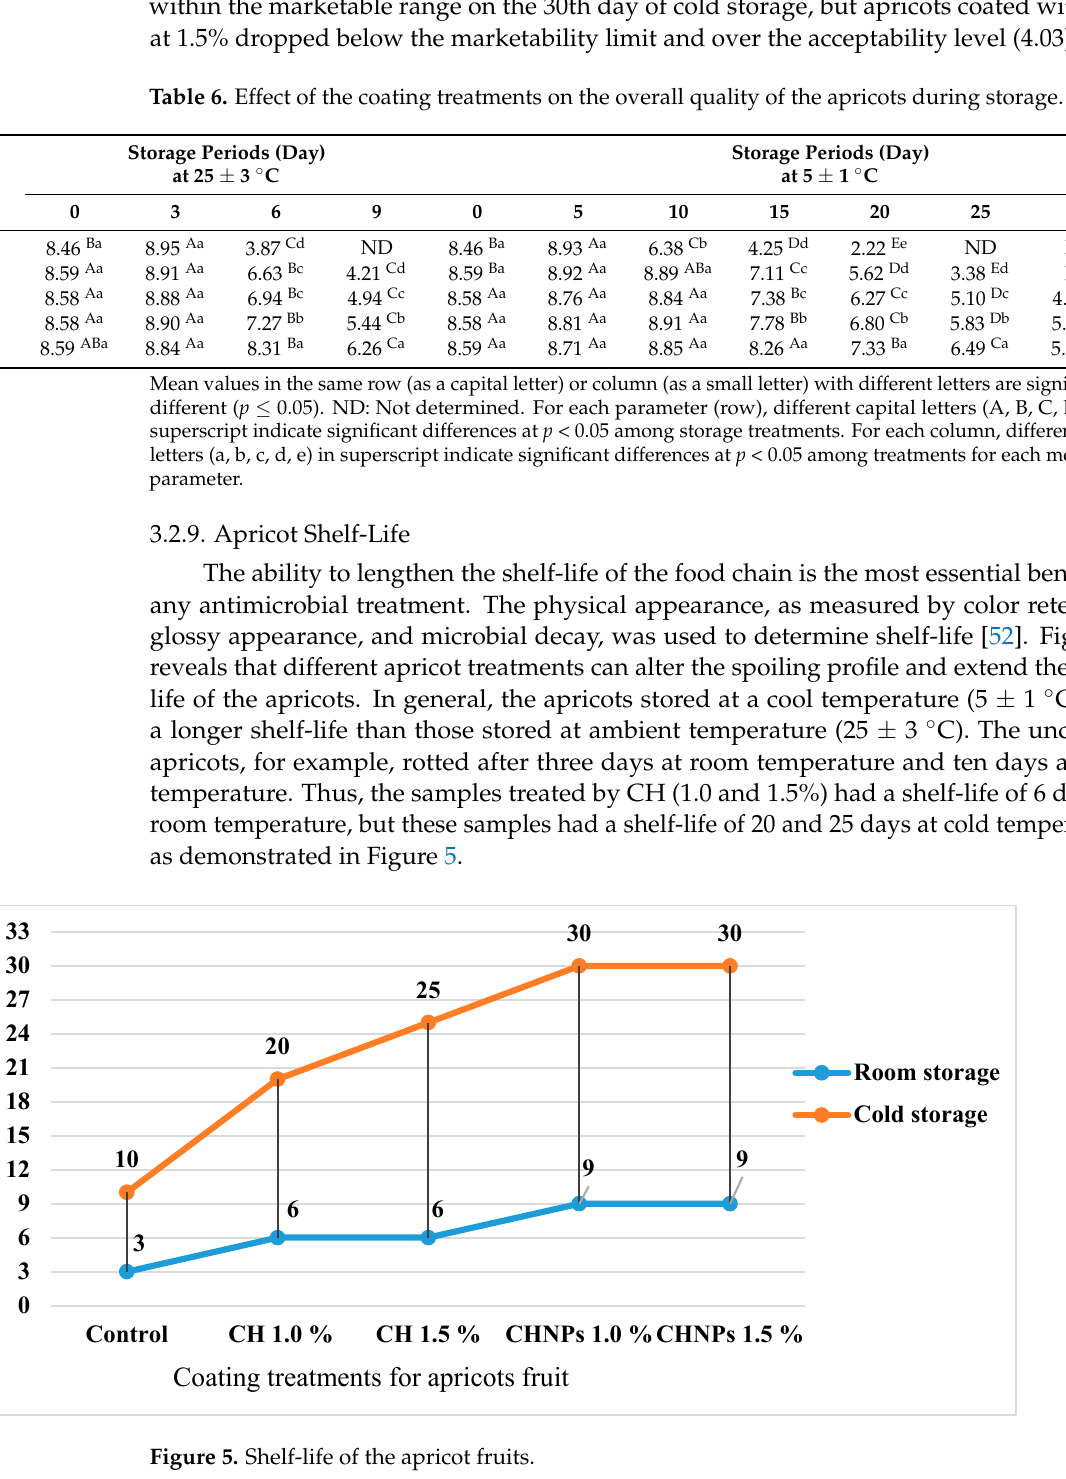
Figure 5. Shelf-life of the apricot fruits. For storage at room and low temperatures, the samples coated with CHNPs at 1.0 and 1.5% had a shelf-life of 9 and 30 days, respectively. The coatings modified the oxygen and carbon dioxide permeation, which affected the respiration of the fruits, and the antimicro- bial activity delayed microbial growth, which reduced the rates of decay [53]. For apricot growers, these are important economic and encouraging